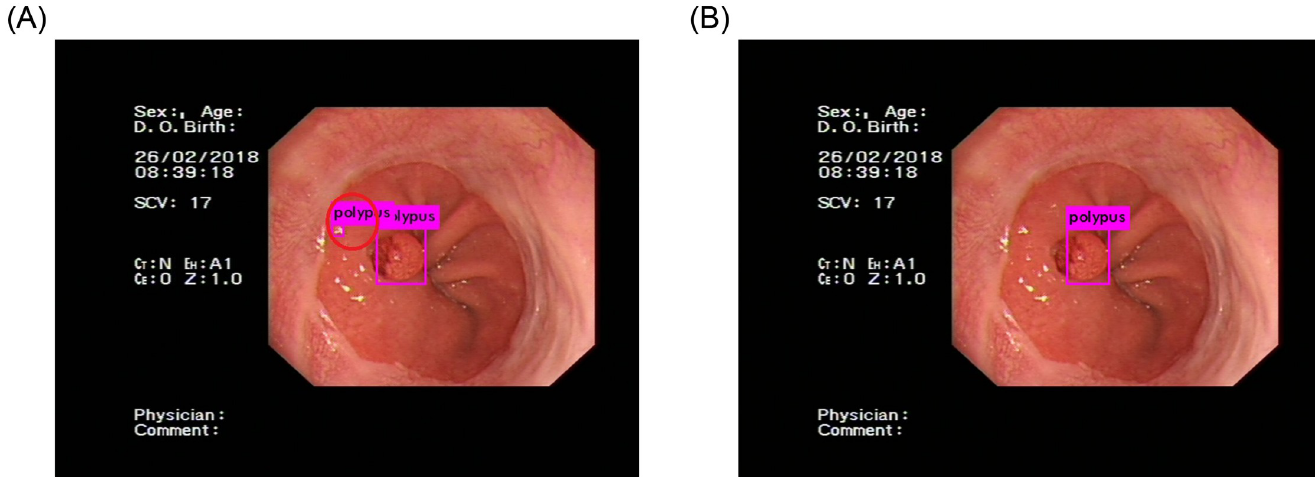
Fig 7. Polyp detection result. (A) is the detection result of the YOLOv3 network, which is incorrect. The background is considered gastric polyps. (B) is the detection result of our network, which is correct.